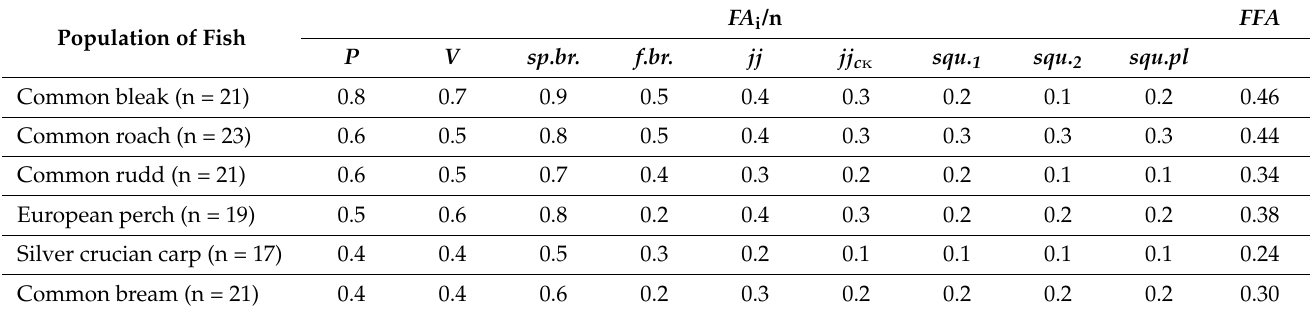
Table 9. The FFA for each studied fish population in the River Styr at sampling site No. 7 ( p ≤ 0.05). Population of Fish